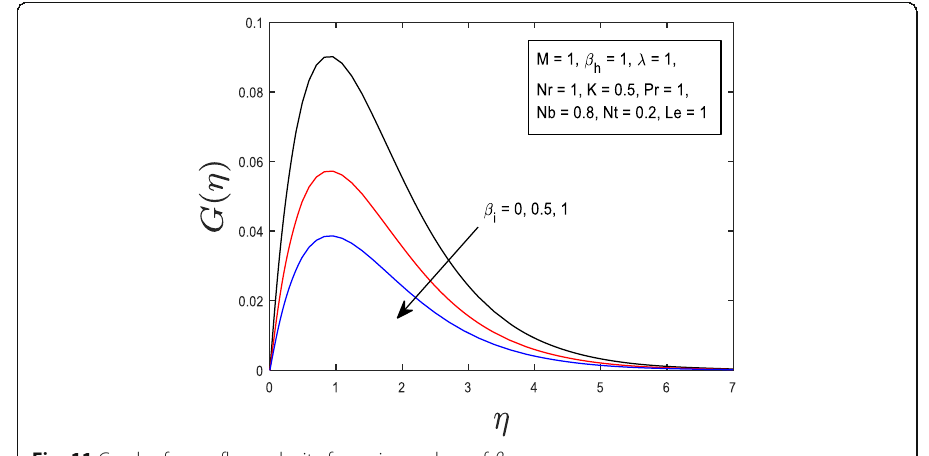
Fig. 11 Graph of cross flow velocity for various values of β i